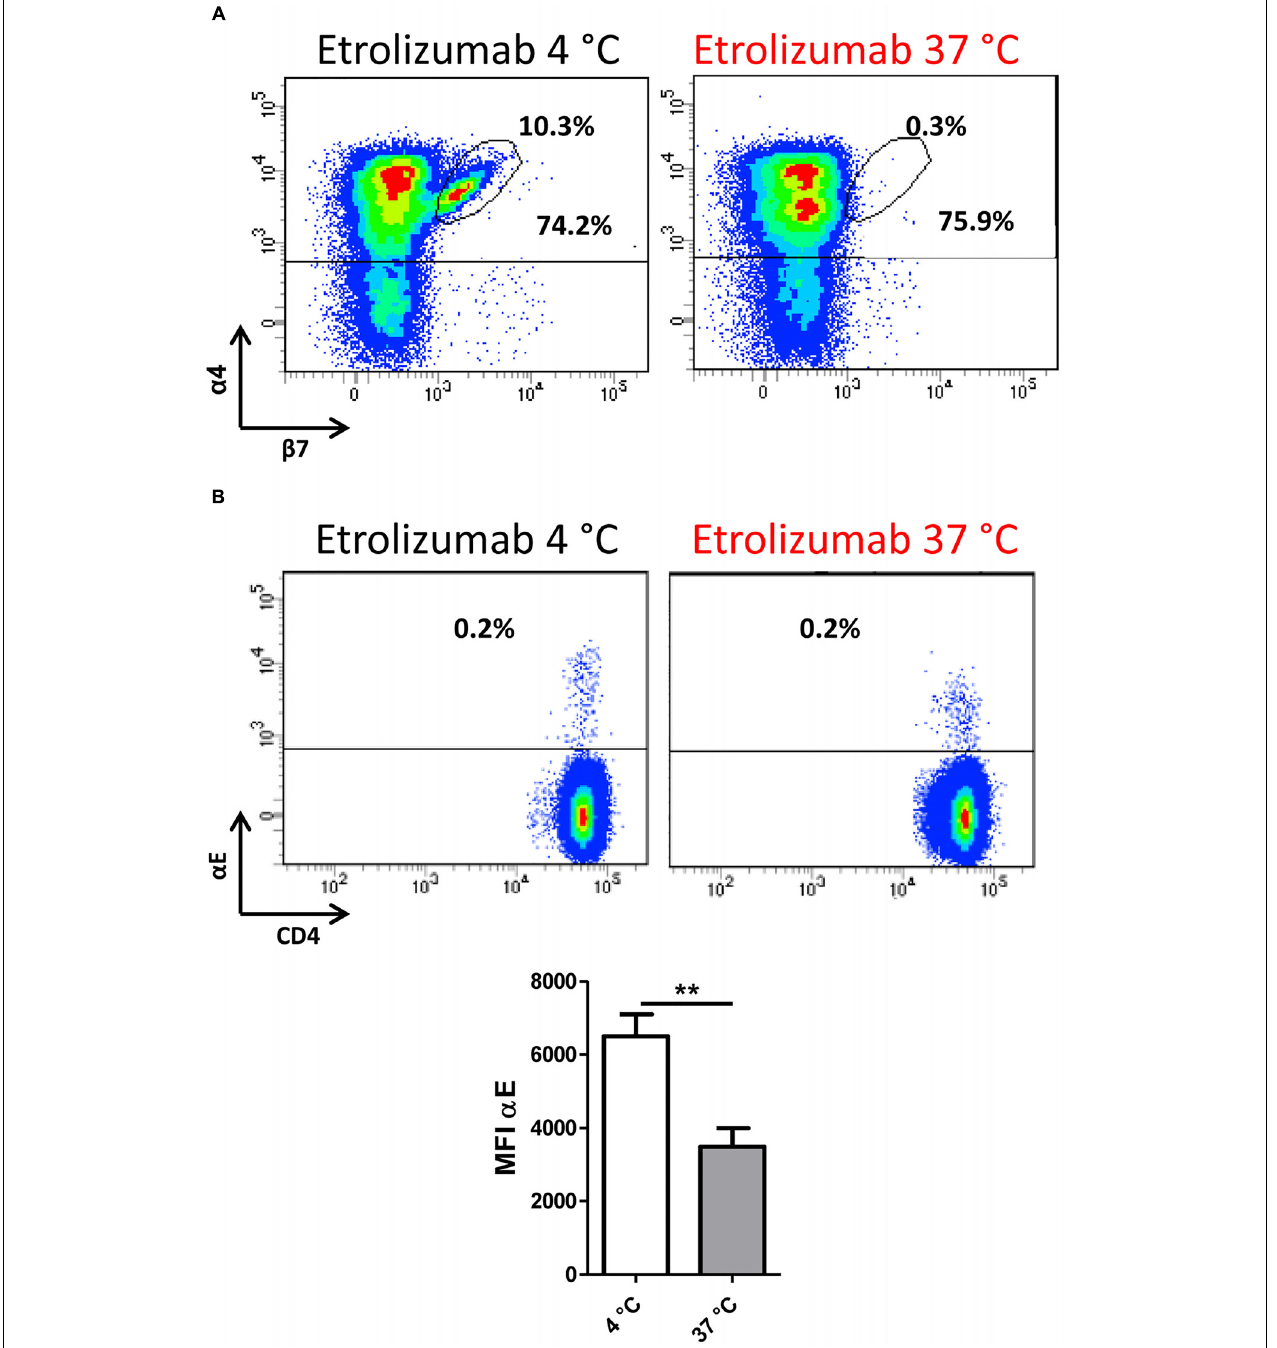
FIGURE 4 | β 7 internalization minimizes α 4 β 7 expression on the cell surface. (A) Representative flow cytometry plot showing expression of α 4 β 7 integrin after treatment with etrolizumab at 4 and 37 ◦ C. Percentages indicate α 4 + β 7 + and total α 4 + cells. (B) Upper panels: Representative flow cytometry plots showing expression of α E integrin after treatment with etrolizumab at 4 and 37 ◦ C. Lower panel: Quantification of β 7 mean fluorescence intensity (MFI) of β 7 + cells ( n = 5). ∗∗ p < 0.01.